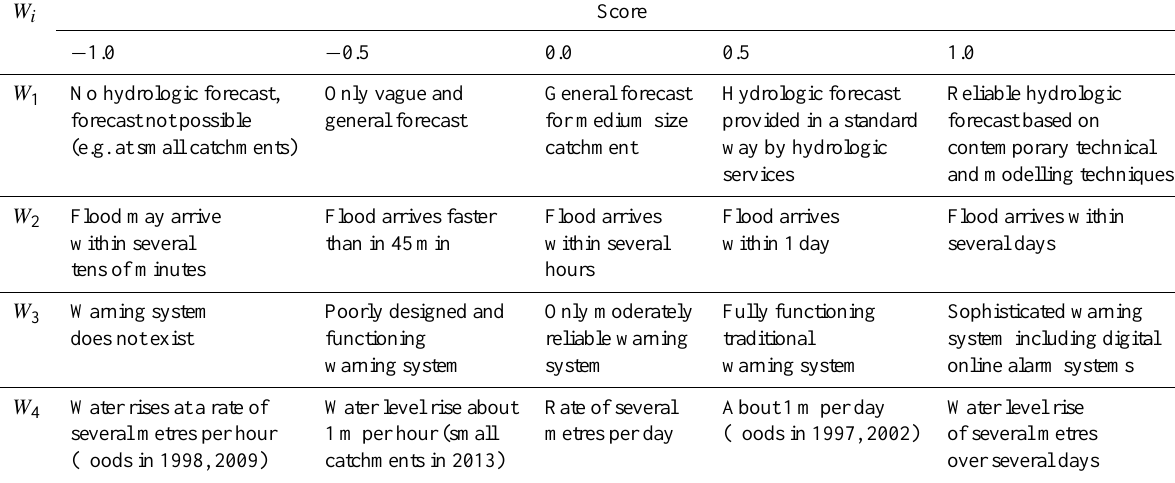
Table 7. Guidance for the scoring of warning items W i . W i Score − 1.0 − 0.5 0.0 0.5 Only vague and General forecast Hydrologic forecast Reliable hydrologic general forecast for medium size provided in a standard forecast based on catchment and modelling